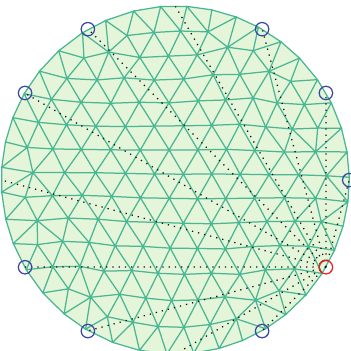
Figure 8: Planar section of a cylindrical medium partitioned with triangular elements. Light is injected at the red point and detection positions are shown in blue. For each measurement, a ray (dotted black) is traced between the corresponding detection position and the injection